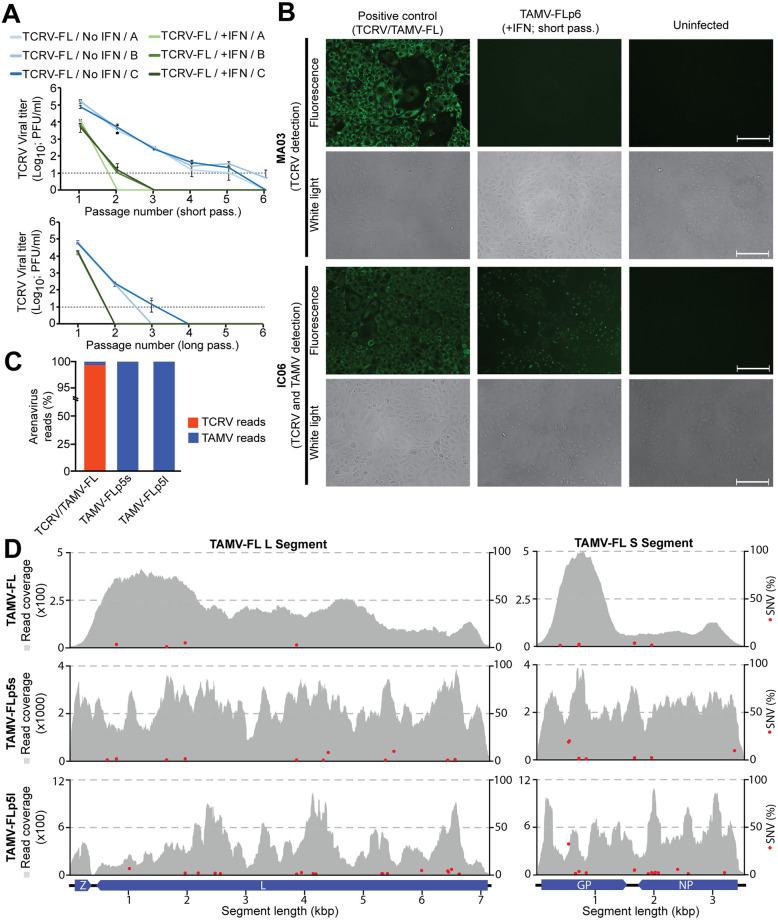
TAMV isolation from tick-derived sample.(A) TCRV viral titers along short (2 days per passage) and long (5 days per passage) passages in A549 cells pretreated or not with 100 IU/ml of IFN. Grey dotted line represent the detection limit of the experiment. Error bars represent standard deviations (n = 4). Biological replicas (A, B and C) are shown independently. (B) Identification of TAMV by IFA in VeroE6 infected cells (48h after infection) with TCS from passage 6 (short format) in presence of IFN (replica A). MA06 antibody recognizes TCRV NP and IC06 antibody recognizes TCRV and TAMV NPs. Scale bars represent 125 μm. (C) Relative abundance of TCRV and TAMV-FL reads obtained by NGS analysis of tick-derived original sample (passage 0, TCRV/TAMV-FL) and of TCS from passage 5 in presence of IFN of short (TAMV-FLp5s) or long (TAMV-FLp5l) passages. (D) TAMV-FL, TAMV-FLp5s and TAMV-FLp5l read coverage (Grey area) and relative abundance of SNV (red dots) of aligned against TAMV-FL sequence.